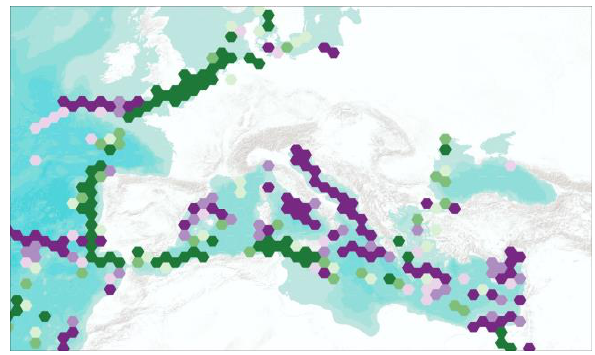
Figure 6 Trend analysis on counted AIS’ positions over all bin locations, focus on Europe/Mediterranean Sea. (Basemap sources: Esri, USGS, NOAA).